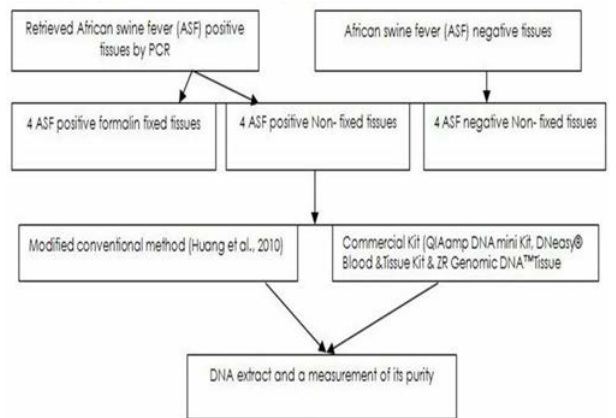
Figure-1: Study design: schematic representation of study